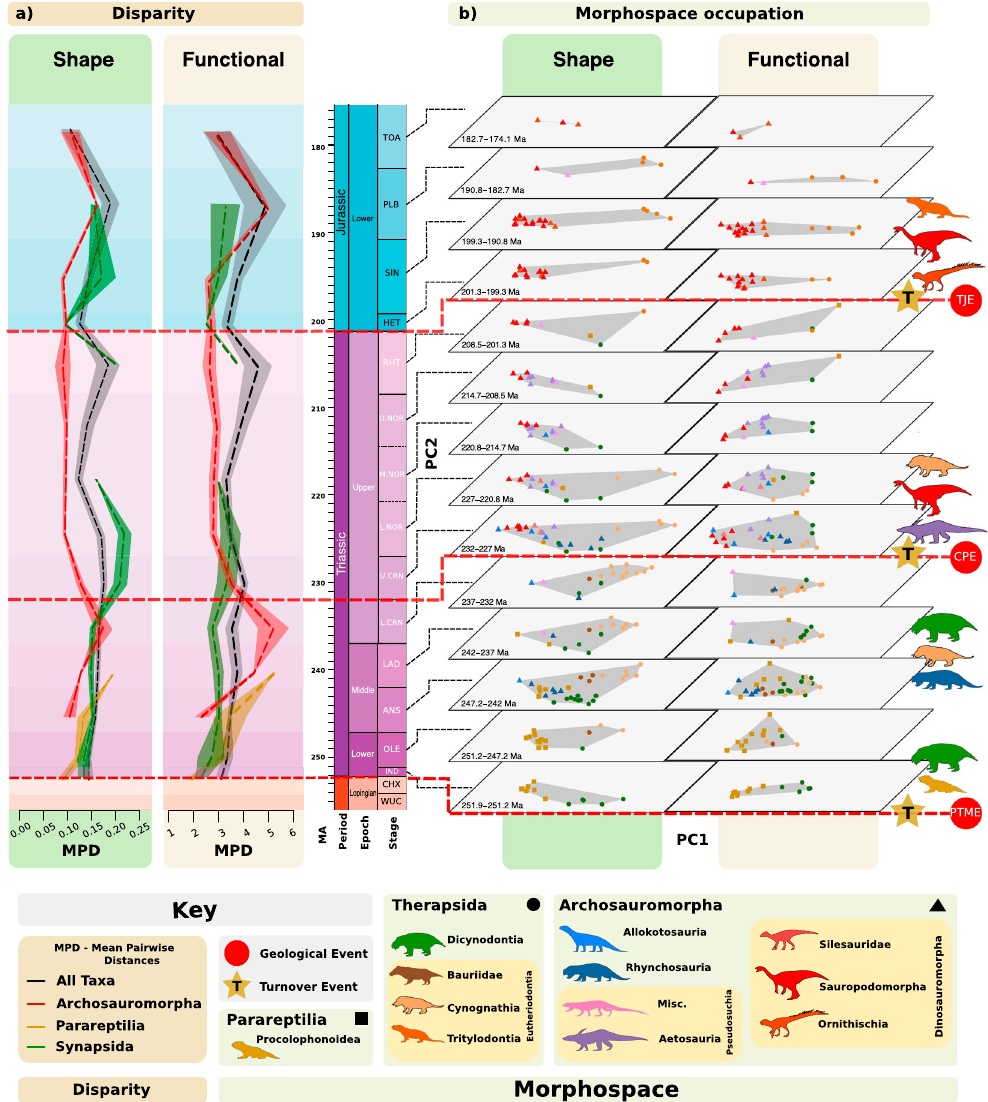
Fig. 5 The shape and functional disparity and morphospace occupation of early Mesozoic herbivores through time. a Shape (Procrustes variance) and functional (sum of variance) disparity of Archosauromorpha, Therapsida, and Parareptilia, with standard error bands. b Shape and functional morphospace time-slices at stage and substage levels. Major extrinsic, environmental events are shown by the dashed red line. Faunal turnovers are highlighted by stars. Misc Miscellaneous pseudosuchians, MPD Mean Pairwise distances, PTME Permo-Triassic mass extinction, CPE Carnian Pluvial Event, TJE Triassic- Jurassic extinction, Timebins: ANS Anisan, CHX Changhsingian, HET Hettangian, IND Induan. L, CRN Lower Carnian, L. NOR Lower Norian, LAD Ladinian, M. NOR Middle Norian, OLE Olenekian, PLB Pliensbachian, RHT Rhaetian, SIN Sinemurian, TOA Toarcian, U. NOR Upper Norian, WUC Wuchiapingian, All silhouettes created by S.S., but some are vectorised from artwork by Felipe Alves Elias (https://www.paleozoobr.com/) and Jeff Martz (United States National Park Service), available for academic use with show near reciprocal traces for therapsids and archosauromorphs — when values for one clade are trending upwards, those for the other are trending downwards. This is particularly apparent in